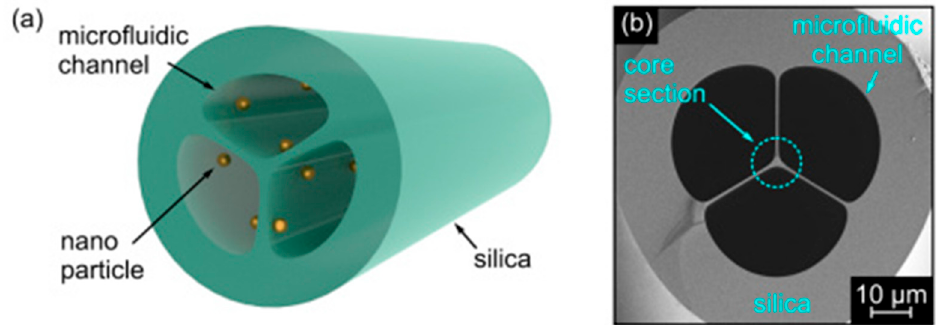
Figure 11. ( a ) Schematic showing the suspended-core MOF functionalized with plasmonic nanoparticles. ( b ) SEM image of the central microstructured section of the investigated MOF. Grey and black areas correspond to silica glass and air, respectively. Adapted with permission from [67]. © The Optical Society.